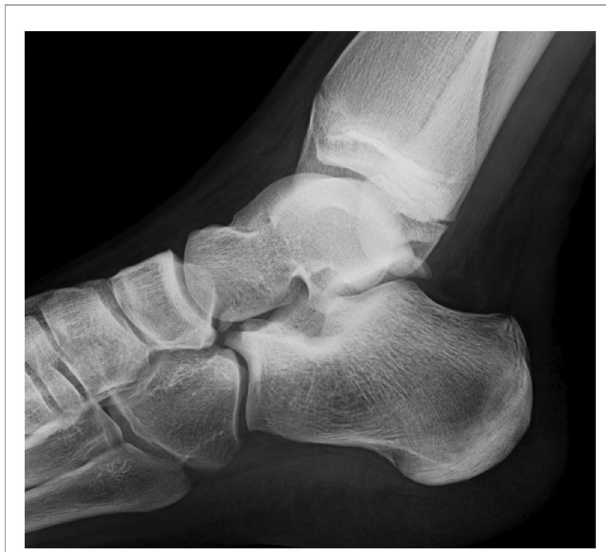
FIGURE 3 | Xray 6 months after surgery con fi rming complete excision of the lesion without residual